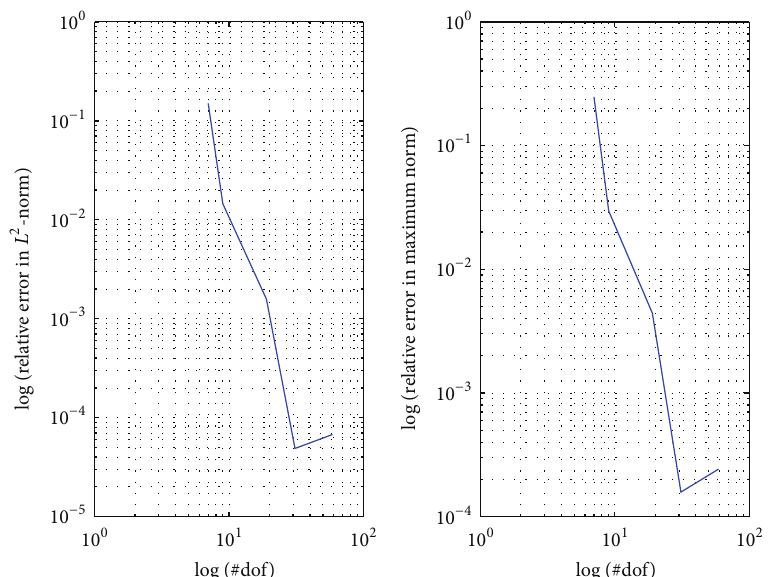
Figure 1: Convergence graphs of relative error in 𝐿 2 -norm and maximum norm via Galerkin method for (42) in Example 1.